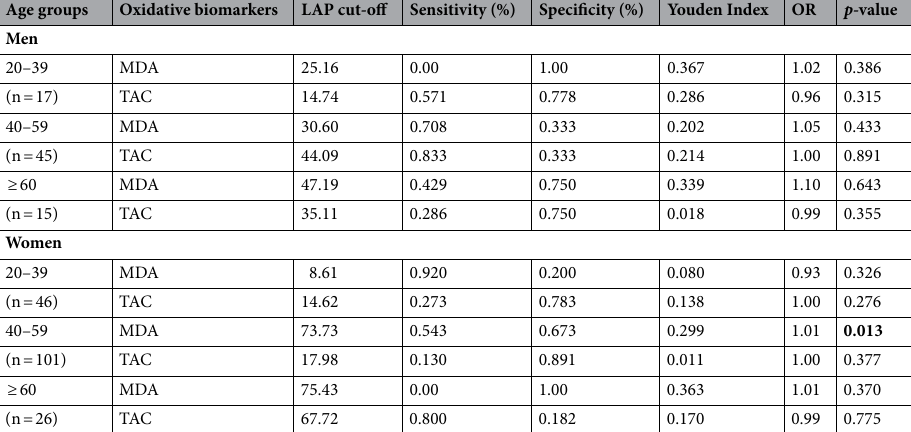
Table 4. Correlation between cut-off points of LAP and oxidative stress biomarkers (MDA and TAC) in men (n = 77) and women (n = 173) by age groups. LAP: lipid product accumulation; MDA: malondialdehyde; TAC: total antioxidant capacity. p-value less than 0.05 was considered statistically